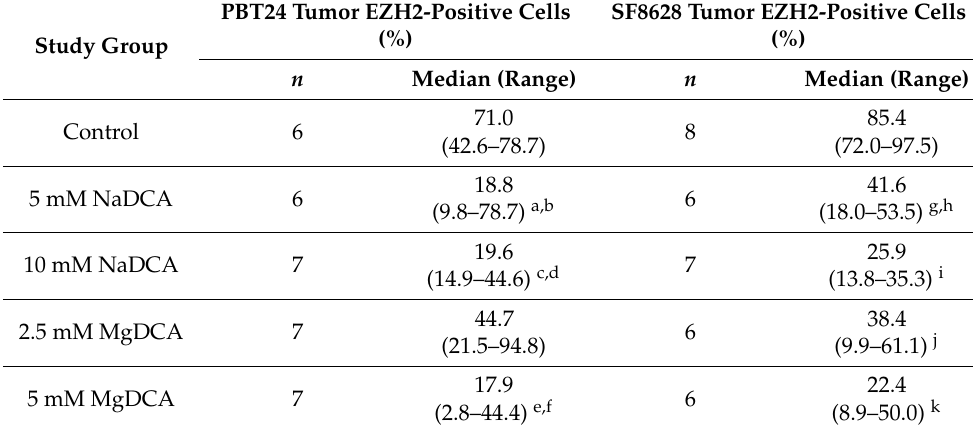
Table 3. The EZH2-positive cells percentage in PBT24 and SF8628 tumors groups.